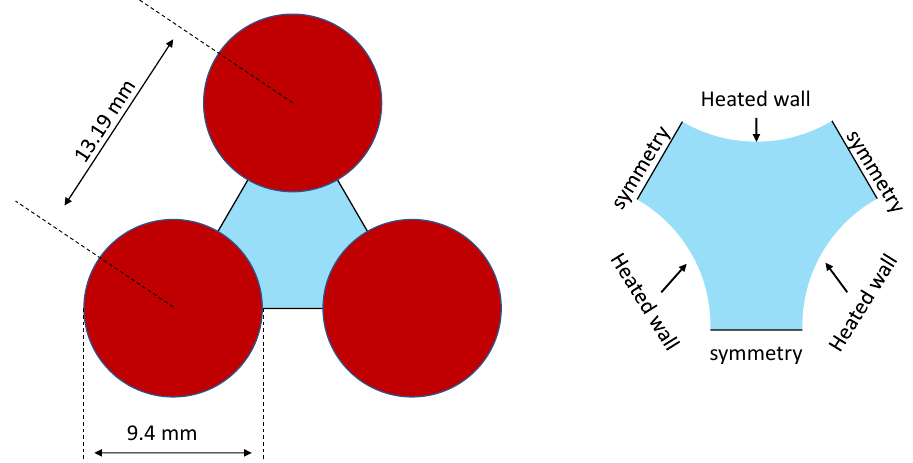
Figure 5. Hexagonal subchannel geometry and boundary conditions.